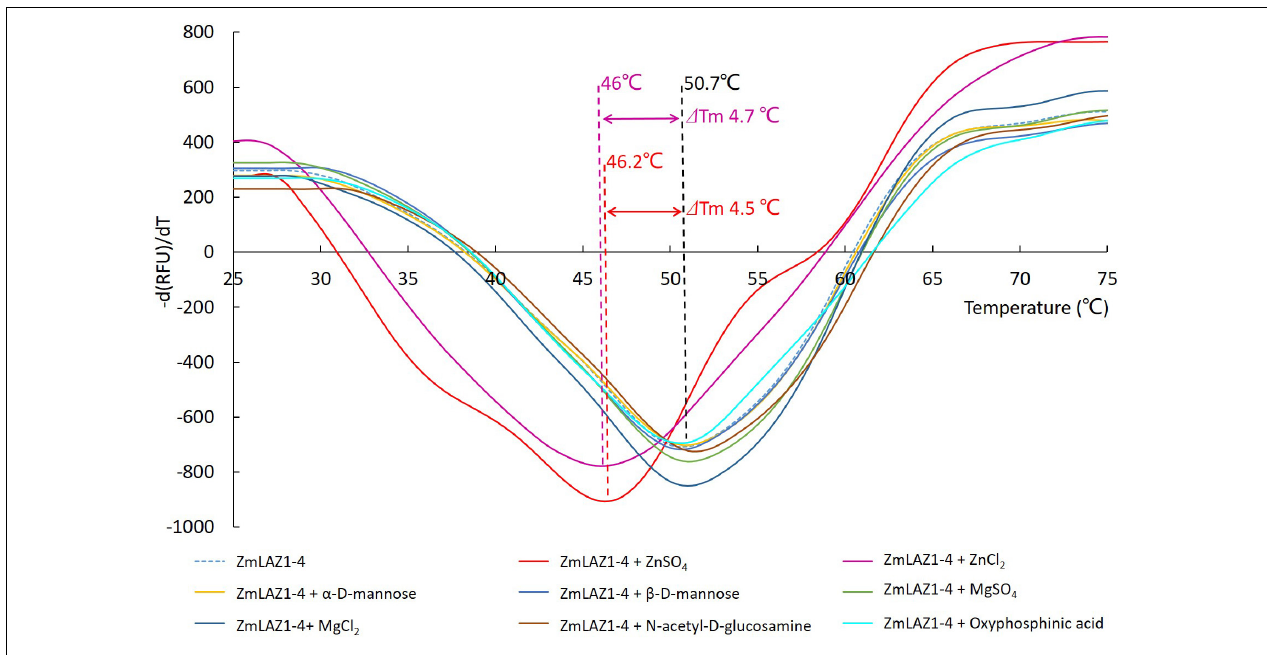
FIGURE 1 | Thermal shift assay of ZmLA1-4 incubated with predicted